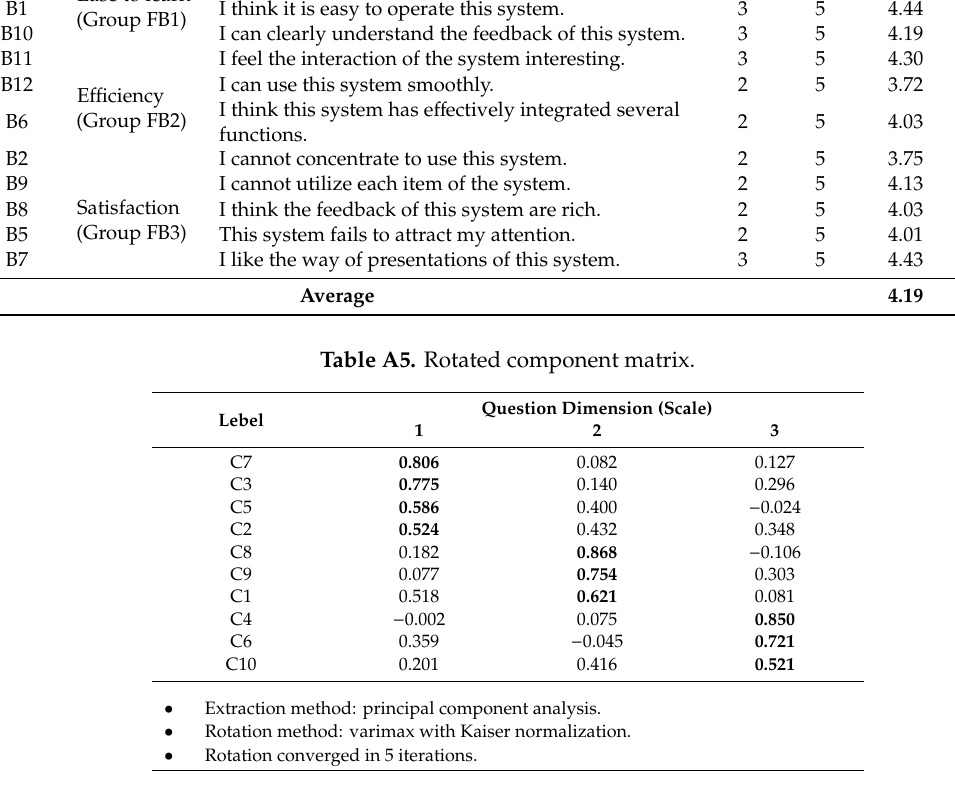
Table A6. Question dimensions (scales) and statistics of questionnaire data of the indicator of “writer’s